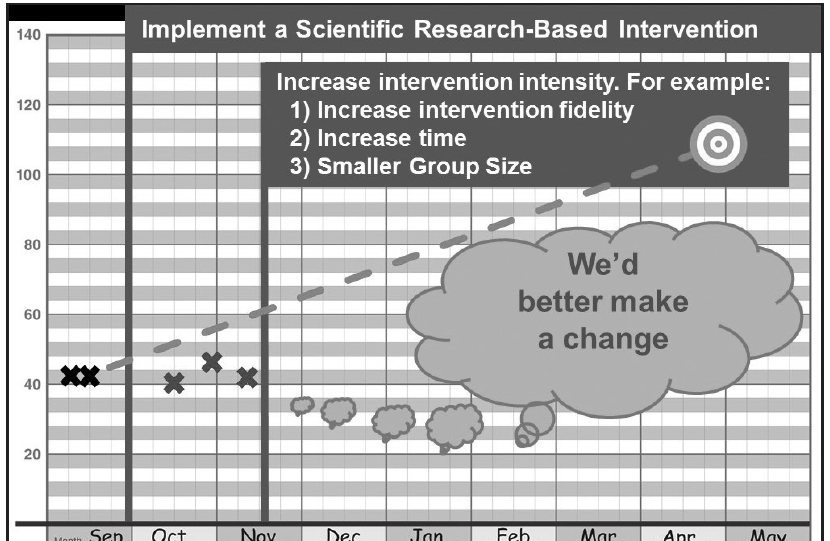
Figure 2: Evaluate and modify